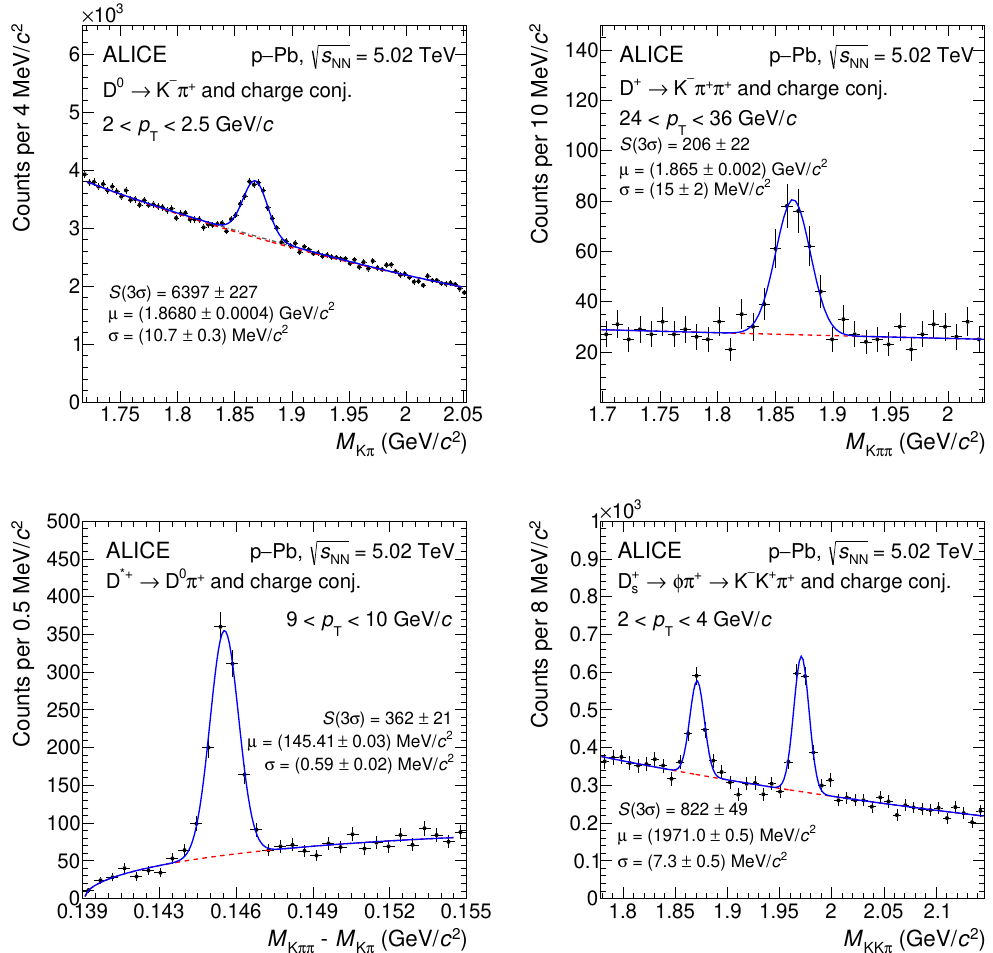
Figure 1 . Examplary invariant-mass distributions for D 0 , D + , and D + candidates (plus charge s conjugates) and the mass di(cid:11)erence (cid:1) M = M K (cid:25)(cid:25) (cid:0) M K (cid:25) for D (cid:3) + candidates (and charge conjugates) p in minimum-bias p{Pb collisions at s = 5 : 02 TeV. The dashed curves represent the (cid:12)t applied NN to the background, while the solid lines represent the total (cid:12)t function. In the case of the D 0 meson, the contribution of signal re(cid:13)ections in the invariant-mass distribution is shown using a gray dot-dashed line. In the case of the D + invariant-mass distribution, an additional Gaussian is s used in the (cid:12)t function in order to describe the D + signal peak on the left side of the D + s